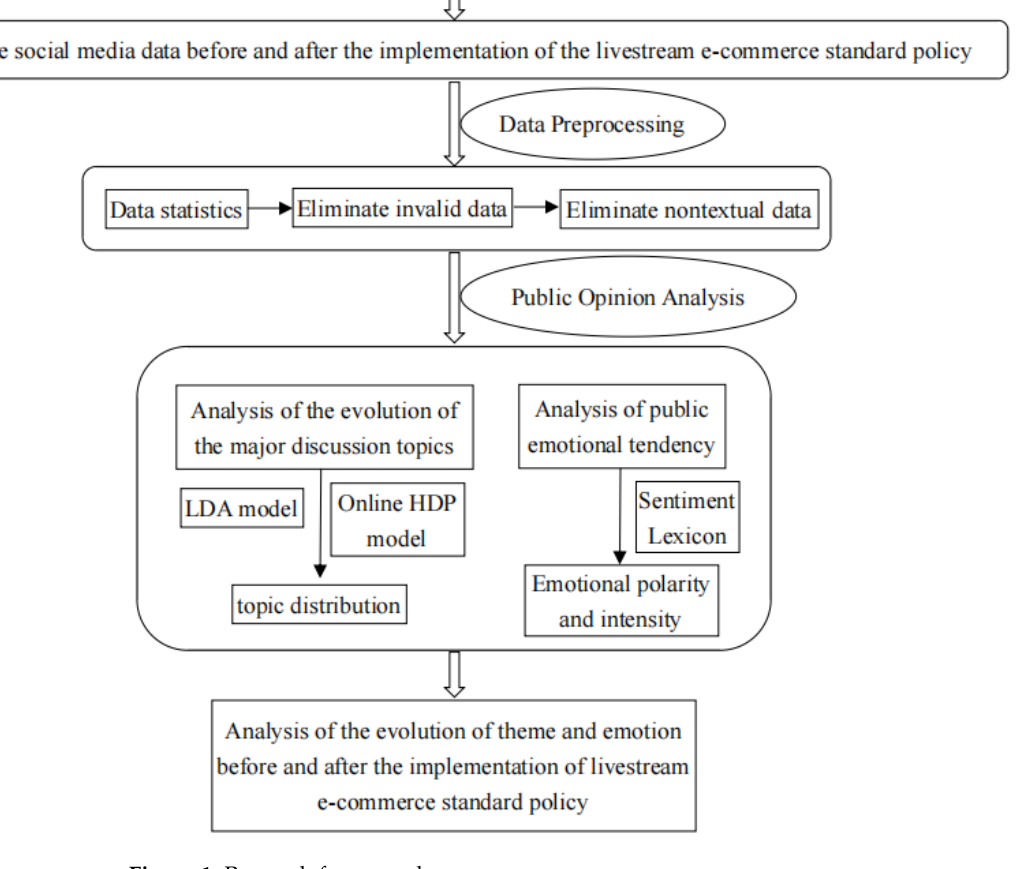
Figure 1. Research